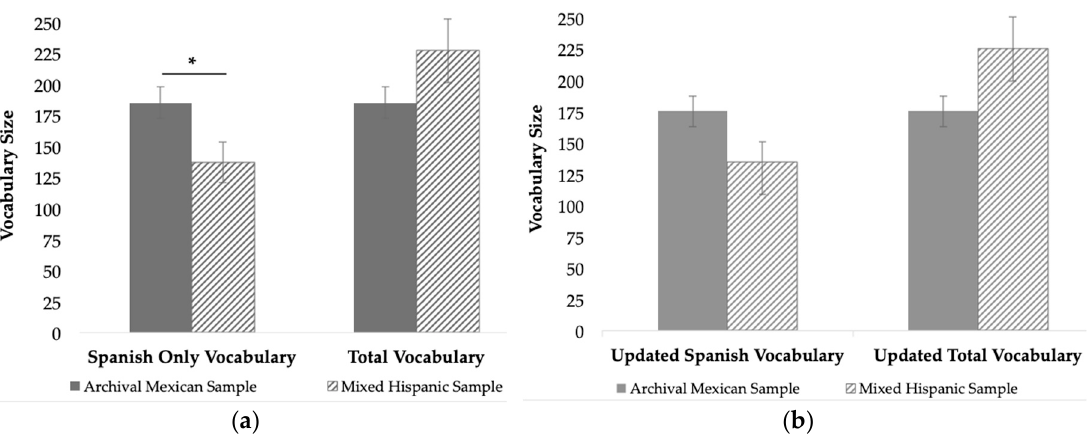
Figure 1. Mean Spanish-only vocabulary size and total vocabulary size for the monolingual archival Mexican sample and the bilingual mixed Hispanic sample ( a ) using the standard IDHC and ( b ) subtracting unknown/uncommon IDHC words. * p < 0.05. See the text for details.